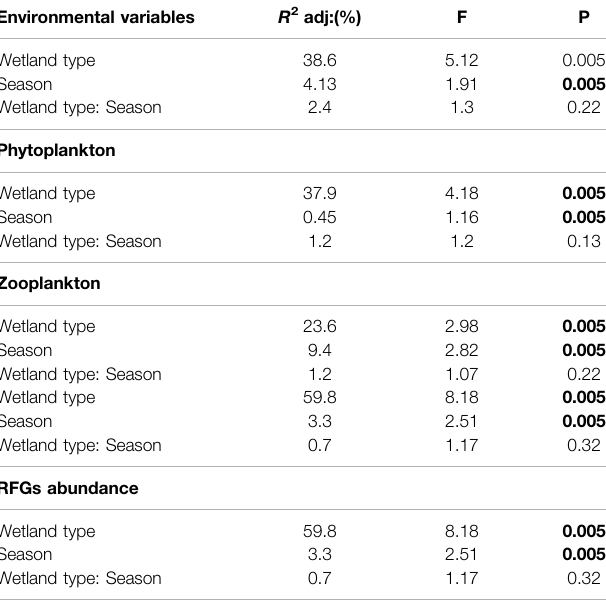
TABLE 1 | Results of redundancy analysis (RDA) testing for the effect of wetland types, season, and their interactions on the environmental variables, plankton community composition, and Reynolds functional